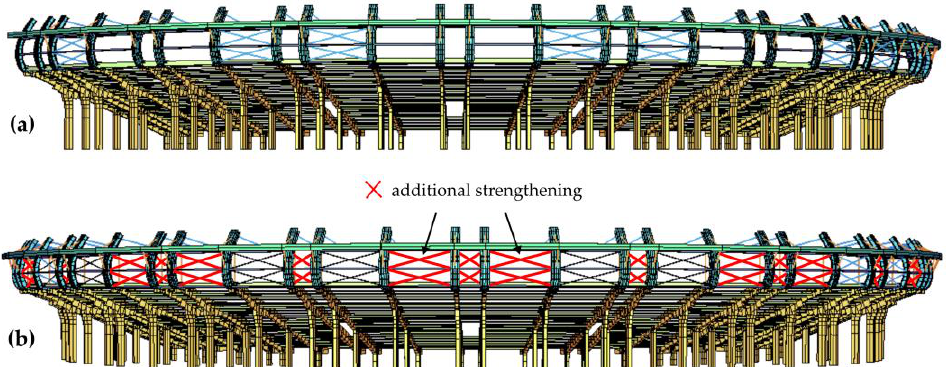
Figure 22. Additional wall bracings ( a ) before structural tuning, ( b ) after structural tuning .